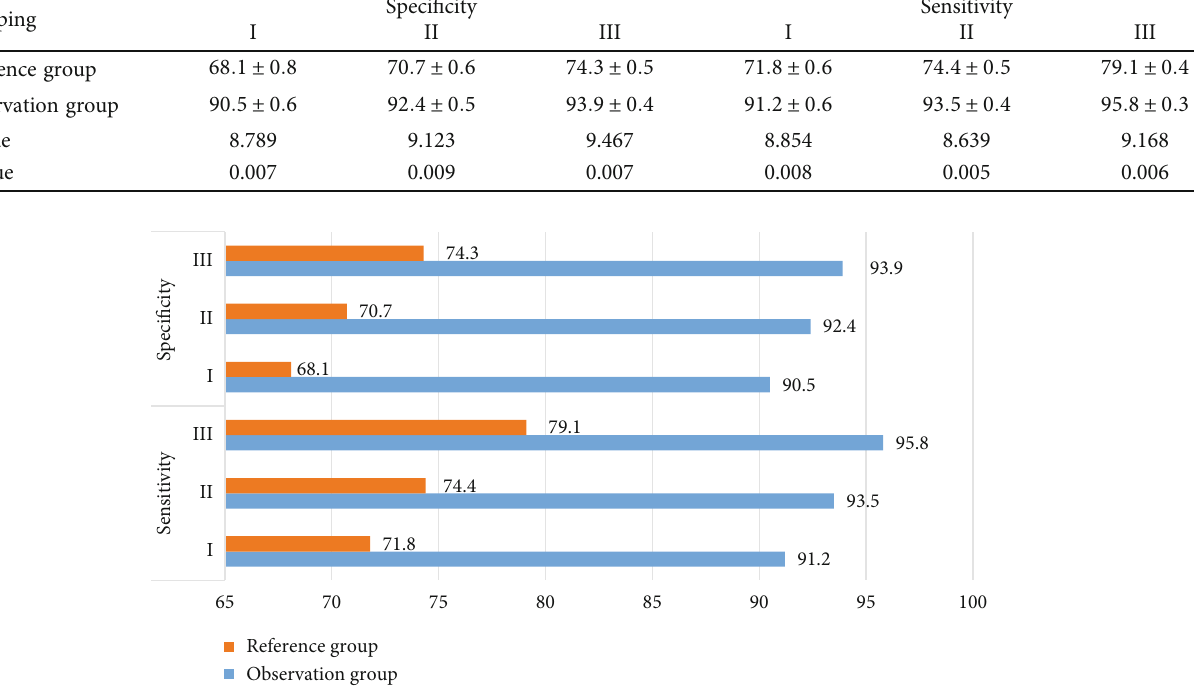
Figure 2: Visual diagram of di ff erent nursing methods for newborns (data source: self-statistics of the study). Table 2: Comparison of nursing quality observation results of di ff erent treatment methods (data source: self-statistics of the study).